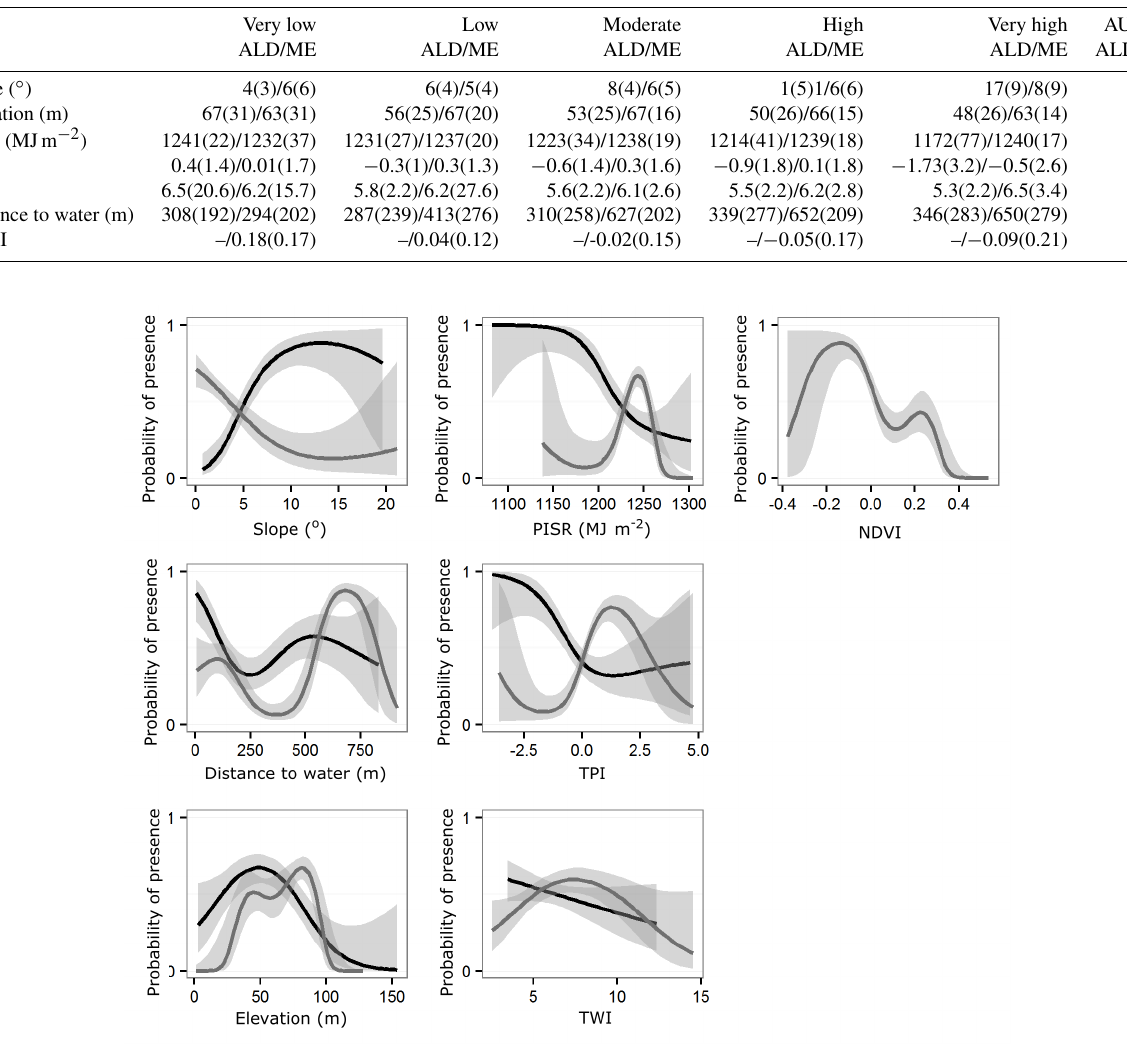
Figure 3. Bivariate plots of the probability of the presence of ALDs (black line) and MEs (grey line) in relations to terrain variables. The grey shading illustrates the 95% confidence bands for each